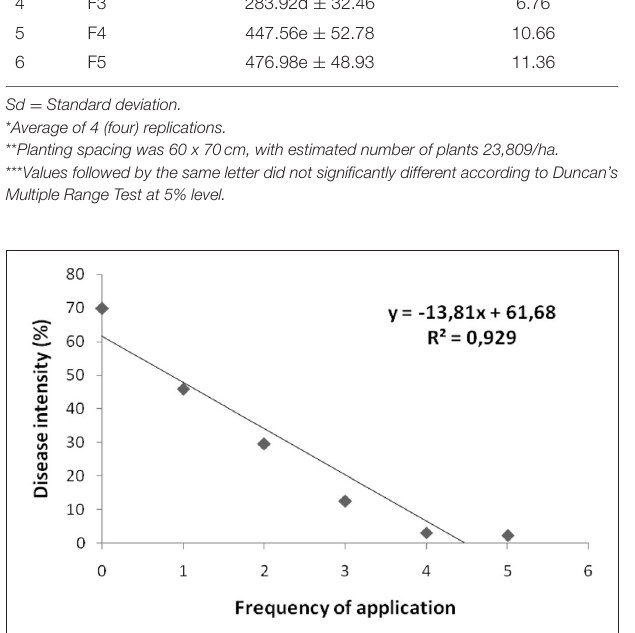
control anthracnose disease on chili pepper cultivar Cabe Besar